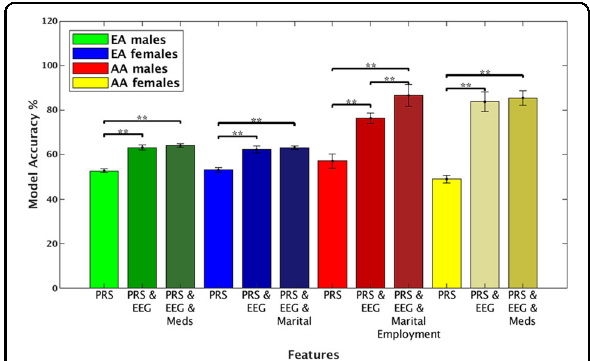
Fig. 1 Model accuracy strati fi ed by sex and ancestry. Prediction obtained by only the PRS, the combined EEG and PRS, and features from the highest accuracy scored model for every group (Table 1). Results indicate higher accuracy for the combined feature models suggesting the advantage of adding phenotypes to genetic prediction models. The error bars are standard deviations. *p < 0.05, **p <